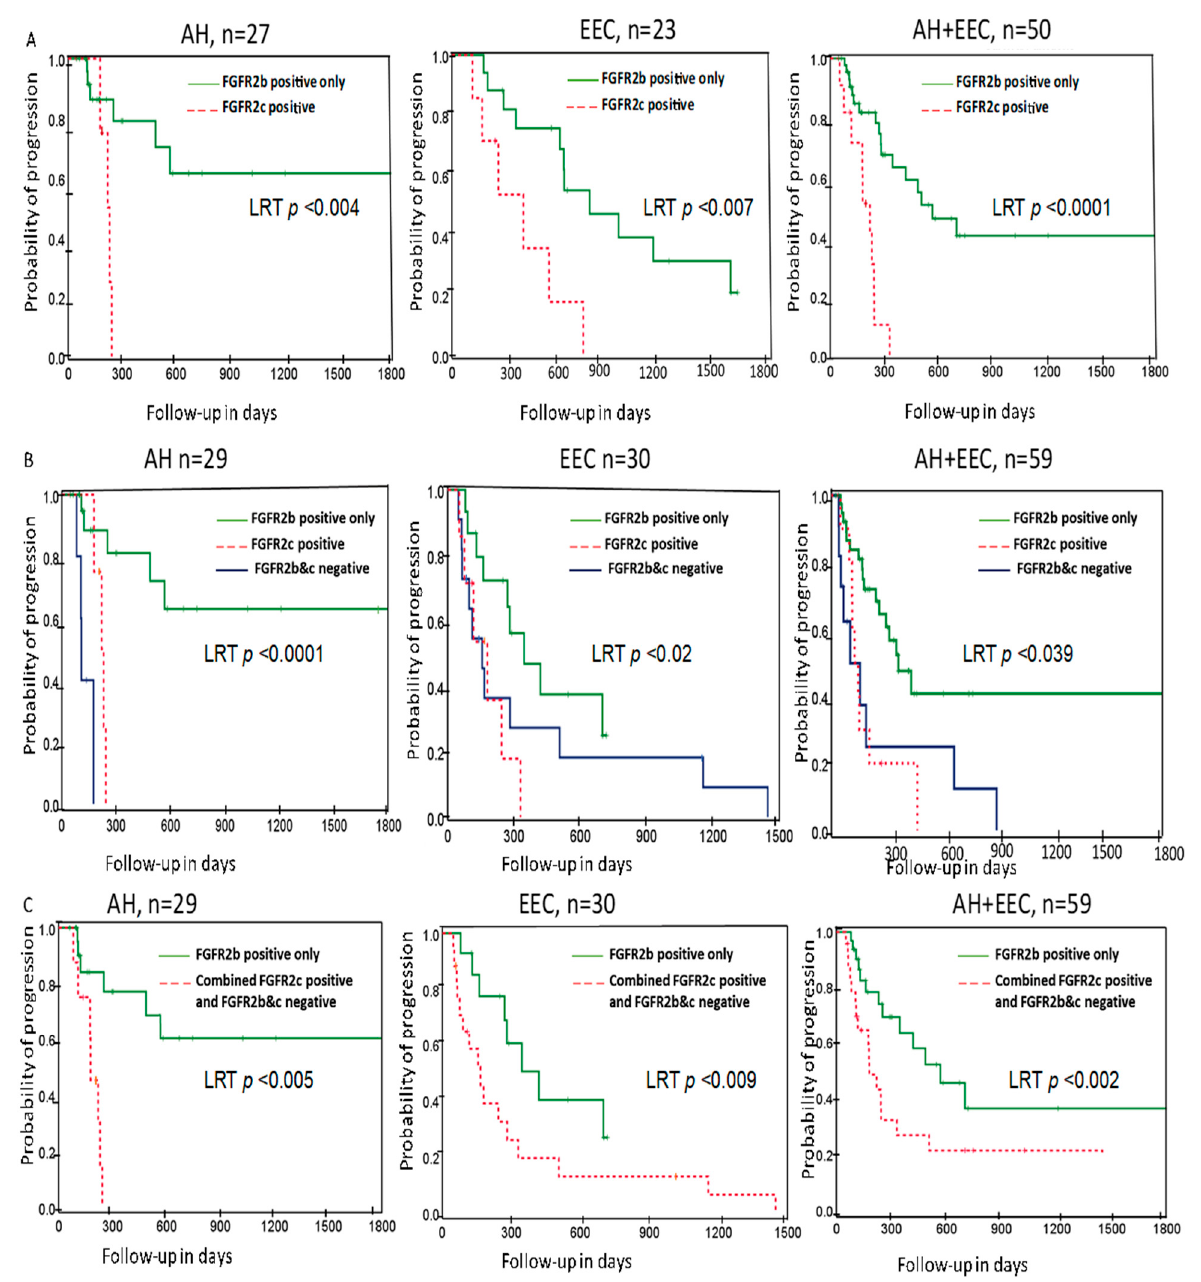
Figure 4. Probability of progression according to the FGFR2 isoform status with and without stratifying by pre-treatment histologic diagnosis in the LNG-IUD treated cohort. Kaplan–Meier curve showing progression probability ( A ) exclusive FGFR2b expression (FGFR2b+/FGFR2c-) vs. FGFR2c positive (FGFR2b+/FGFR2c+) cases. ( B ) exclusive FGFR2b (FGFR2b+/FGFR2c-) vs. FGFR2c positive (FGFR2b+/FGFR2c+) vs. negative for both isoforms (FGFR2b-/FGFR2c-) ( C ) exclusive FGFR2b expression (FGFR2b+/FGFR2c-) vs. FGFR2c positive (FGFR2b+/FGFR2c+) combined with negative for both isoforms (FGFR2b-/FGFR2c-). AH, atypical hyperplasia; EEC, Endometrioid endometrial carcinoma; FGFR2c, Fibroblast Growth Factor Receptor 2c isoform; LRTP, Log Rank Test Probability. Table 3. Association of clinicopathologic parameters and outcome with FGFR2 isoform status in 89 women.